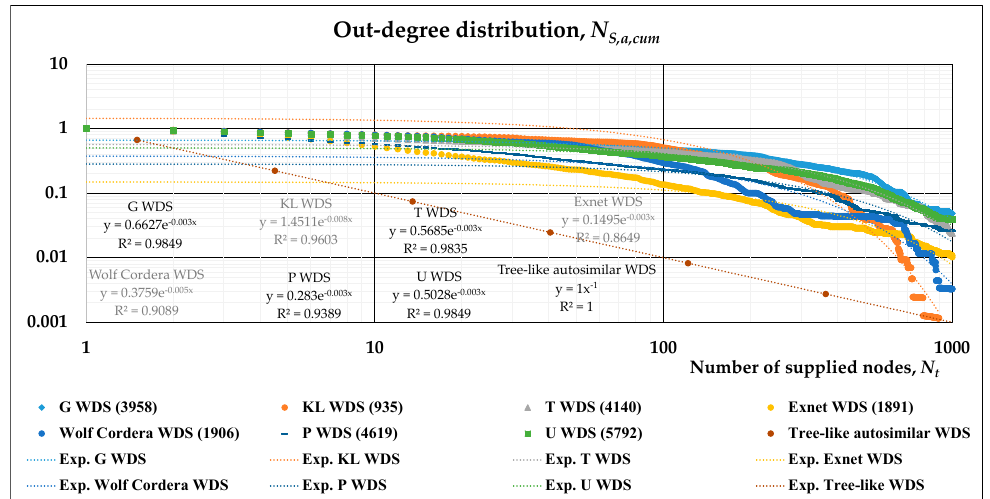
Figure 3. Log ‐ log plot of cumulative out ‐ degree distribution function for several WDSs, together with Figure 3. Log-log plot of cumulative out-degree distribution function for several WDSs, together with an overall exponential fitting. The tree ‐ like auto ‐ similar network of Figure 1 is also indicated, with its an overall exponential fitting. The tree-like auto-similar network of Figure 1 is also indicated, with its power ‐ law distribution. power-law